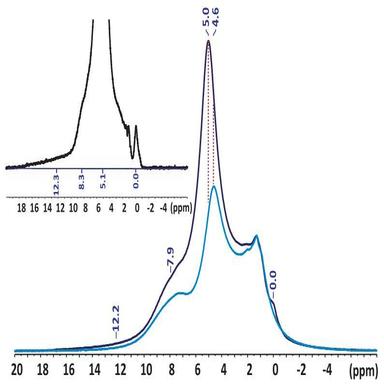
1H MAS NMR spectra (νr = 60 kHz, relaxation delay 10s) of Hu-dentin (black) and Dm-dentin (blue). Insert: spectral difference between the two spectra.